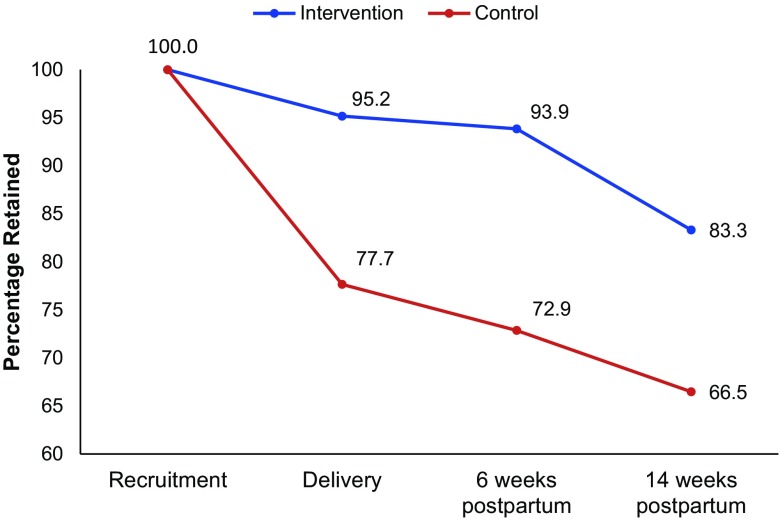
Participant Retention in Care at Delivery and 6 Weeks and 14 Weeks Postpartum, Kisumu, KenyaFollowed until delivery: intervention, 197/207; control, 153/197.Followed until 6 weeks postpartum: intervention, 183/195; control, 137/188. Denominators exclude 17 participants total with still births (intervention, 9; control, 8) and 4 participants with infant deaths (intervention, 3; control, 1).Followed until 14 weeks postpartum: intervention, 160/192; control, 125/188. Denominator for the intervention arm excludes 2 participants with infant deaths after 6 weeks postpartum.